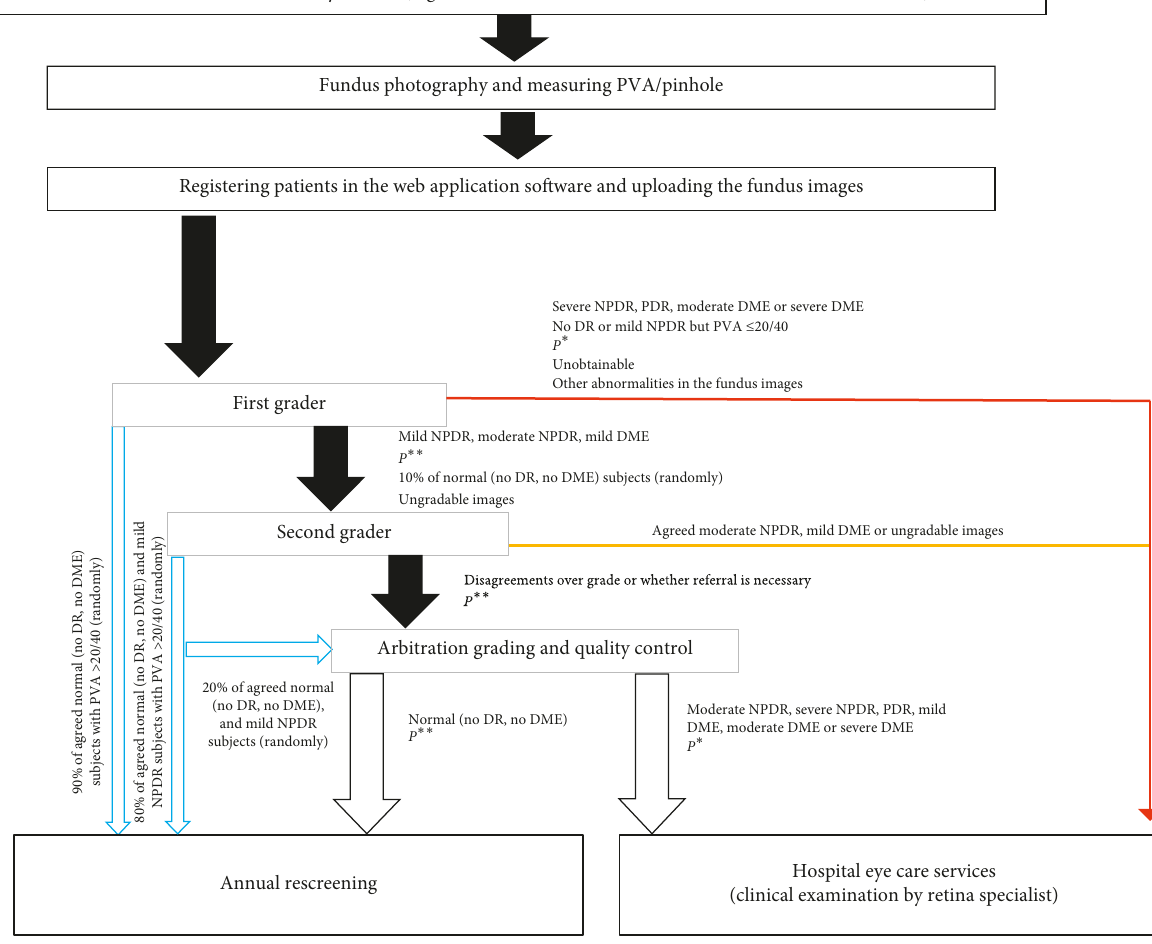
Figure 1: Patient care and referral pathway. DME: diabetic macular edema; DR: diabetic retinopathy; NPDR: nonproliferative diabetic retinopathy; PDR: proliferative diabetic retinopathy; MPC: macular photocoagulation; PRP: panretinal photocoagulation; PVA: presenting visual acuity. P ∗ : “evidence of PRP:active PDR” or “evidence of MPC: nonresolved DME”; P ∗∗ : “evidence of PRP: regressed PDR” or “evidence of MPC:resolved DME.” Blue: annual rescreening; orange: nonurgent referral; red: urgent